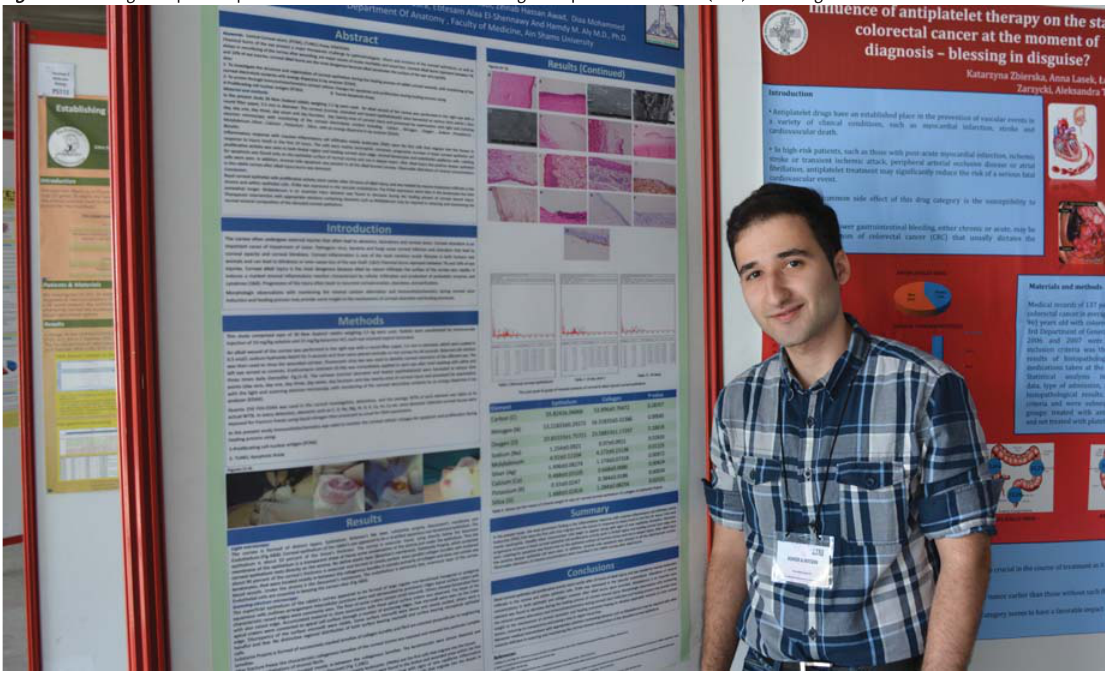
Figure 1. During the poster presentation session at 8th Young European Scientists (YES)